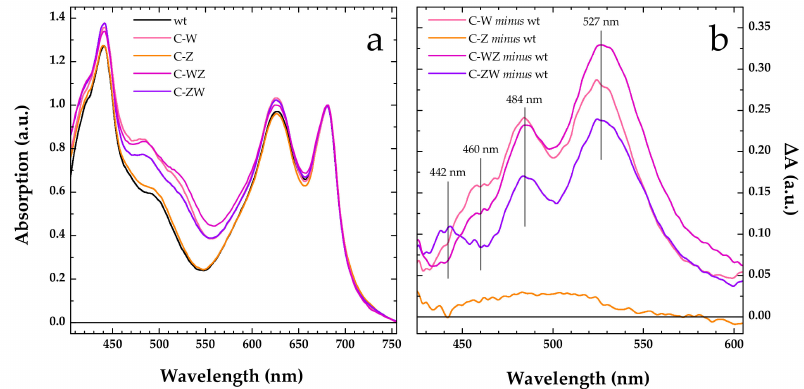
Figure 1. Whole cells absorption spectra. ( a ) Comparison of absorption spectra of wild-type (wt, black line) and engineered Synechocystis strains constitutively expressing Brevundimonas CrtW (C-W, pink line), CrtZ (C-Z, orange line), CrtW and CrtZ in tandem (C-WZ, purple line), CrtZ and CrtW in tandem (C-ZW, violet line). All spectra are normalised at their maximal Qy absorbance (680 nm). ( b ) Comparison of the di ff erence spectra “engineered strain minus wild-type” in the 425–605 nm window, colour coding as for the engineered strains in panel ( a ). The main spectral features of the di ff erence spectra are marked by vertical solid lines and the wavelength indicated.